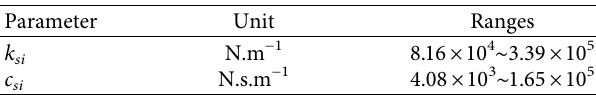
Figure 12: The process of dynamic parameter allocation optimization of the suspension system. Table 4: Range of dynamic parameters of the tracked vehicle suspension.